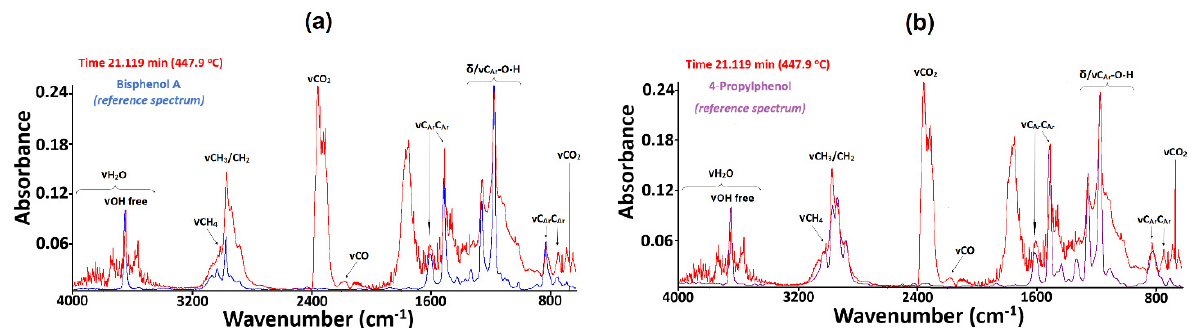
Figure 7. Experimental infrared spectra of gaseous products (shown in red) recorded at different atmosphere, along with FTIR spectra of references (shown in blue): ( a ) bisphenol A (air); ( b ) 4- propylphenol (nitrogen).